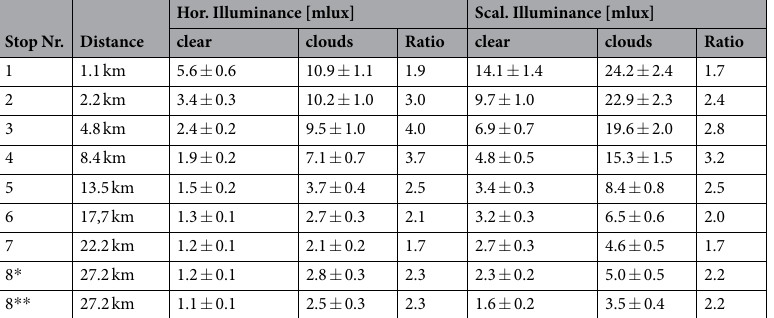
Table 2. List of the illuminance values for the two nights at the different locations along the transect (see methods for details). Please note that the values for the last measurement site show data from earlier in the night (8 * ) and later in the night (8 **